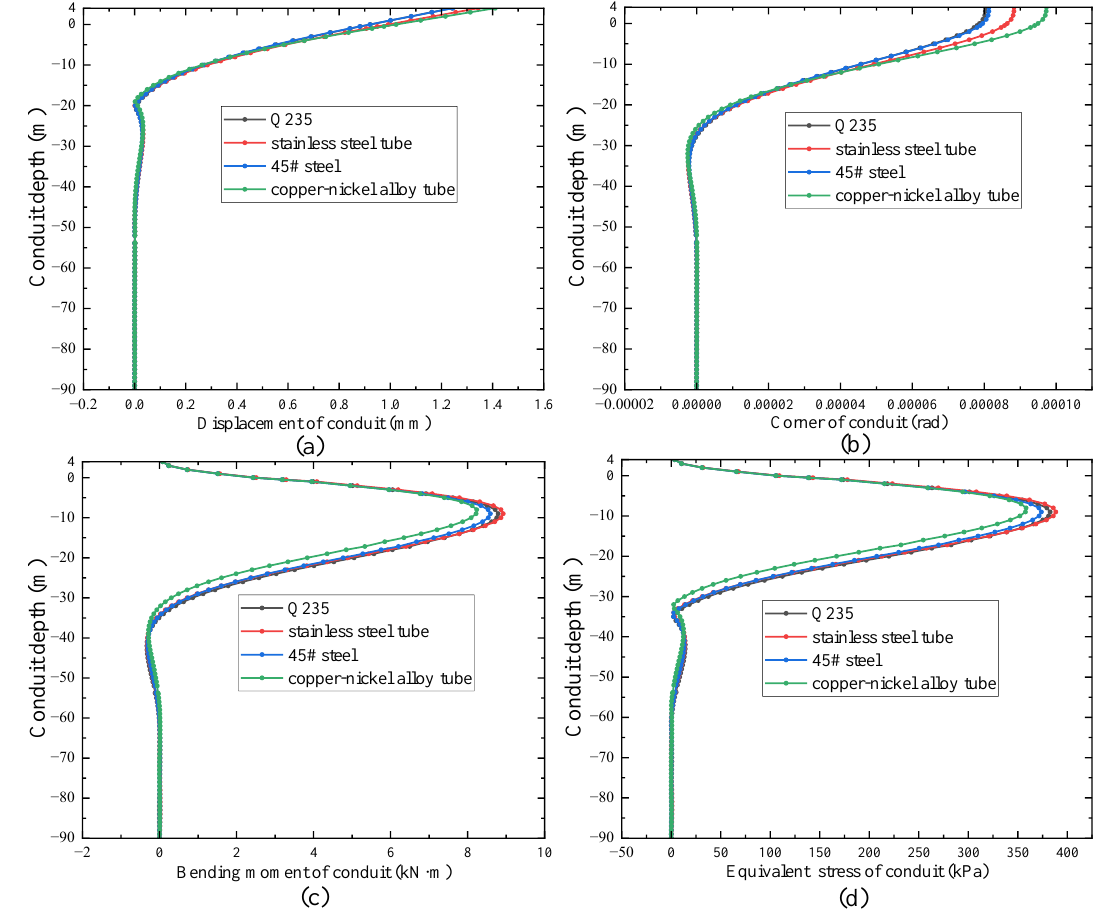
Figure 6. ( a ) Effect of conductor material on conductor displacement, ( b ) Effect of conductor material on conductor turning angle, ( c ) Effect of conductor material on conductor bending moment, ( d ) Effect of conductor material on conductor equivalent force.